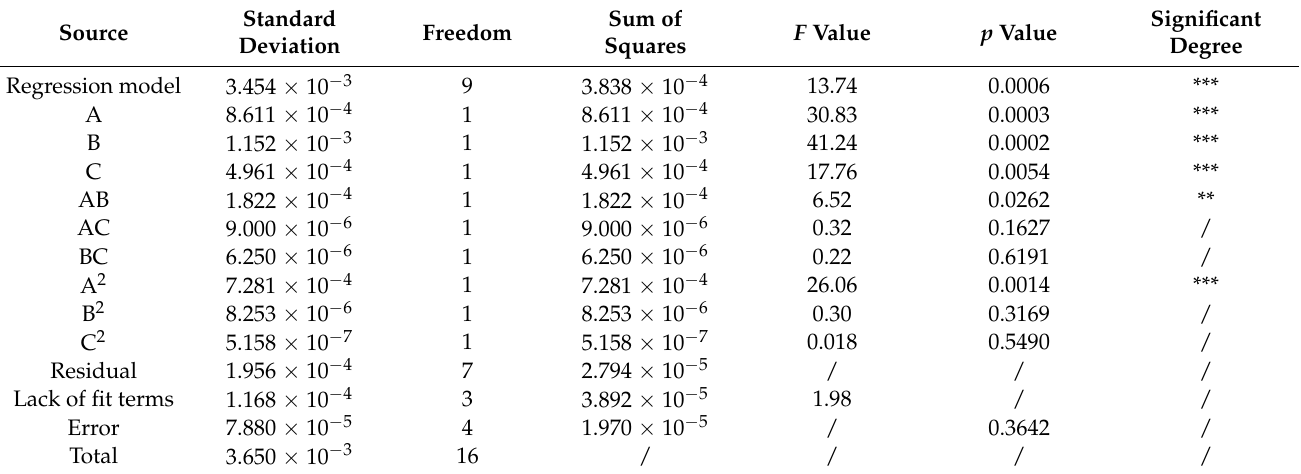
Table 10. ANOVA of the grain breakage